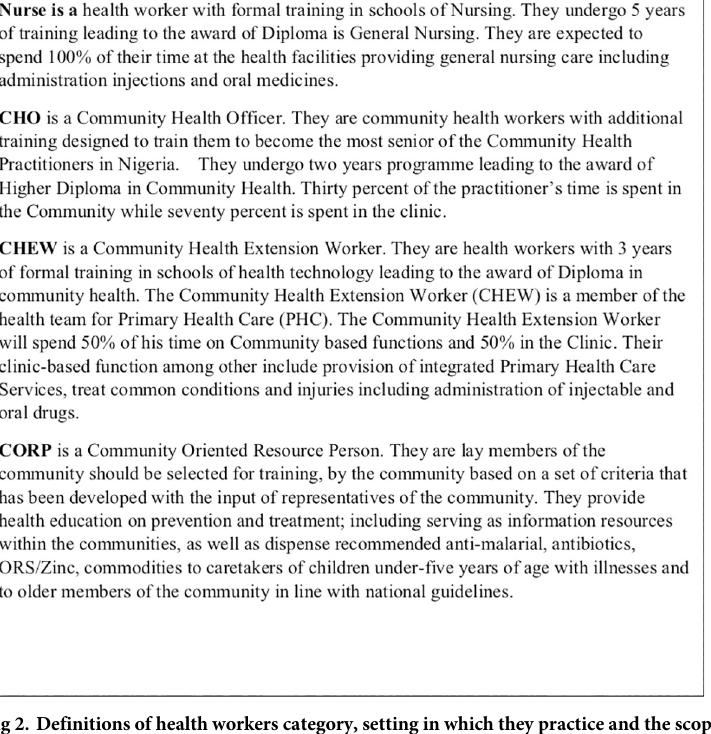
Fig 2. Definitions of health workers category, setting in which they practice and the scope of their